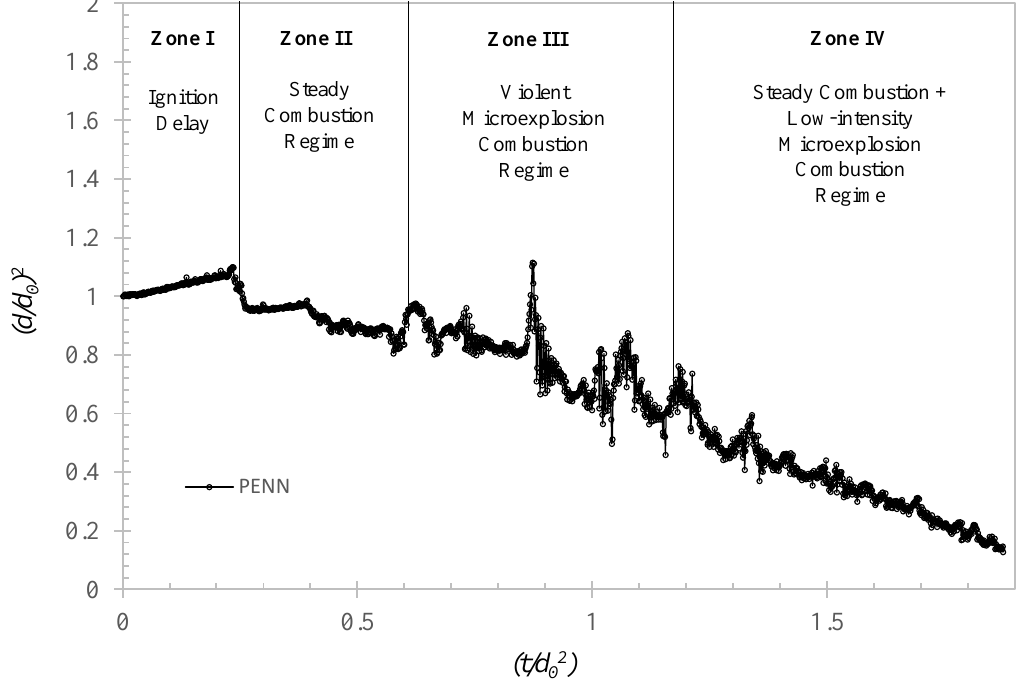
Figure 5. The evolution of ( d / d 0 ) 2 with time for Pennsylvania crude oil with various combustion zones ( d 0 = 0.79 mm) .